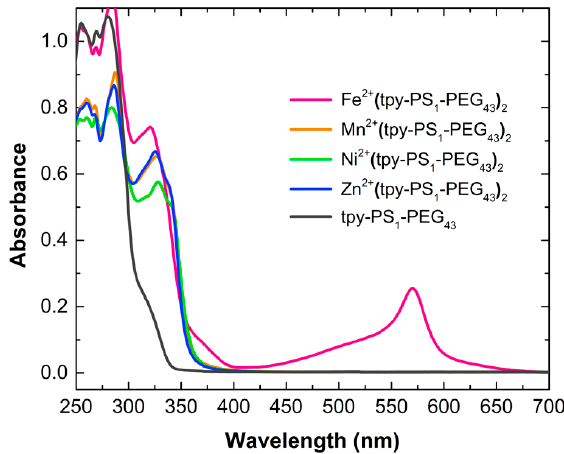
Figure 2. UV-Vis absorption spectra of tpy-PS 1 -PEG 43 and its derived metallo-polymers, M(tpy-PS 1 -PEG 43 ) 2 , in dichloromethane solutions at a typical sample concentration of 0.03 mM.